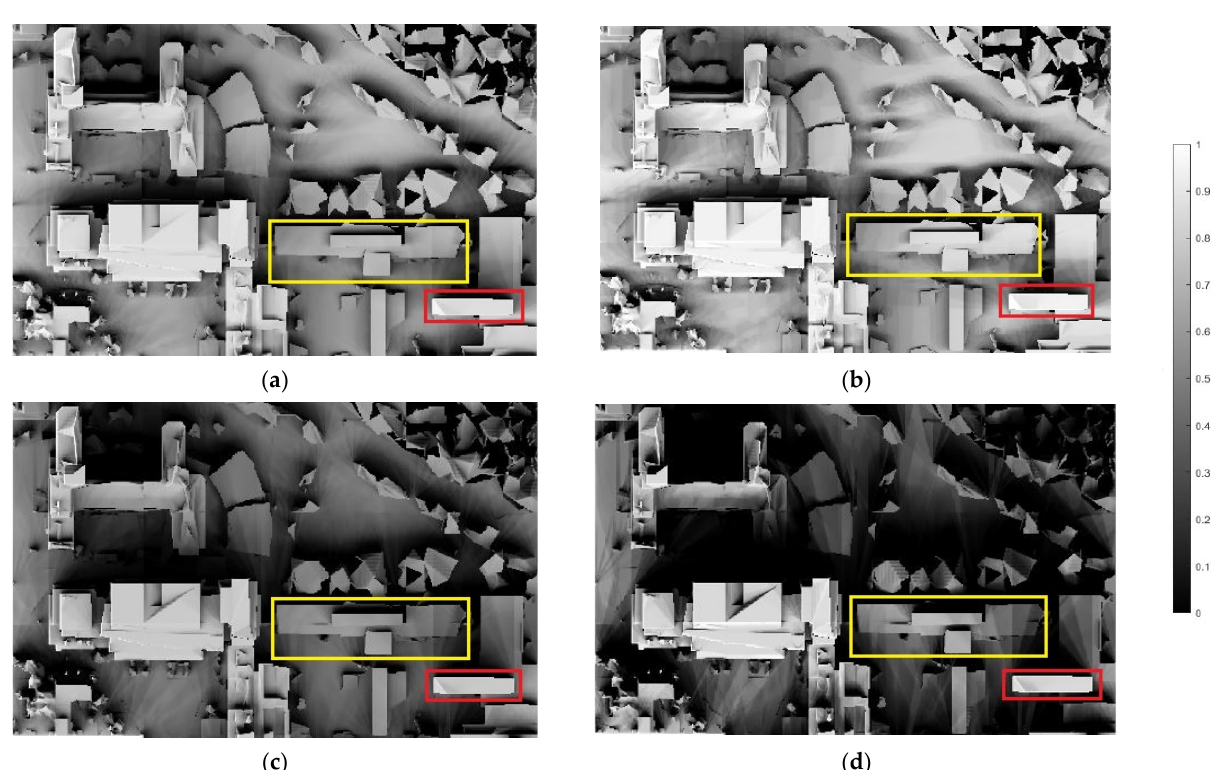
Figure 13. Average brightness score for the EAS building in ( a ) spring, ( b ) summer, ( c ) fall, and ( d ) winter.